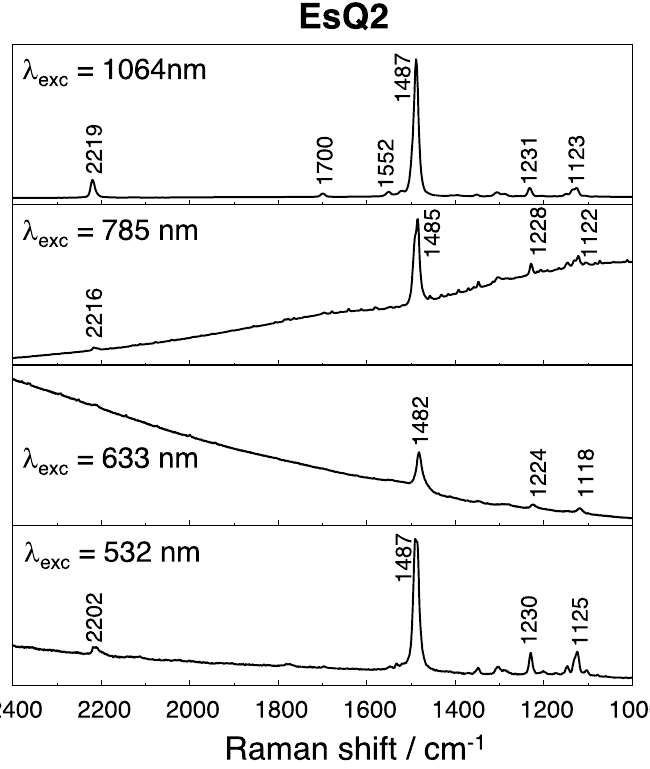
Figure 5. Raman spectra of EsQ2 measured in the solid state at room temperature with different excitation wavelengths: from top to bottom: 1064 nm; 785 nm; 633 nm; 532 nm.